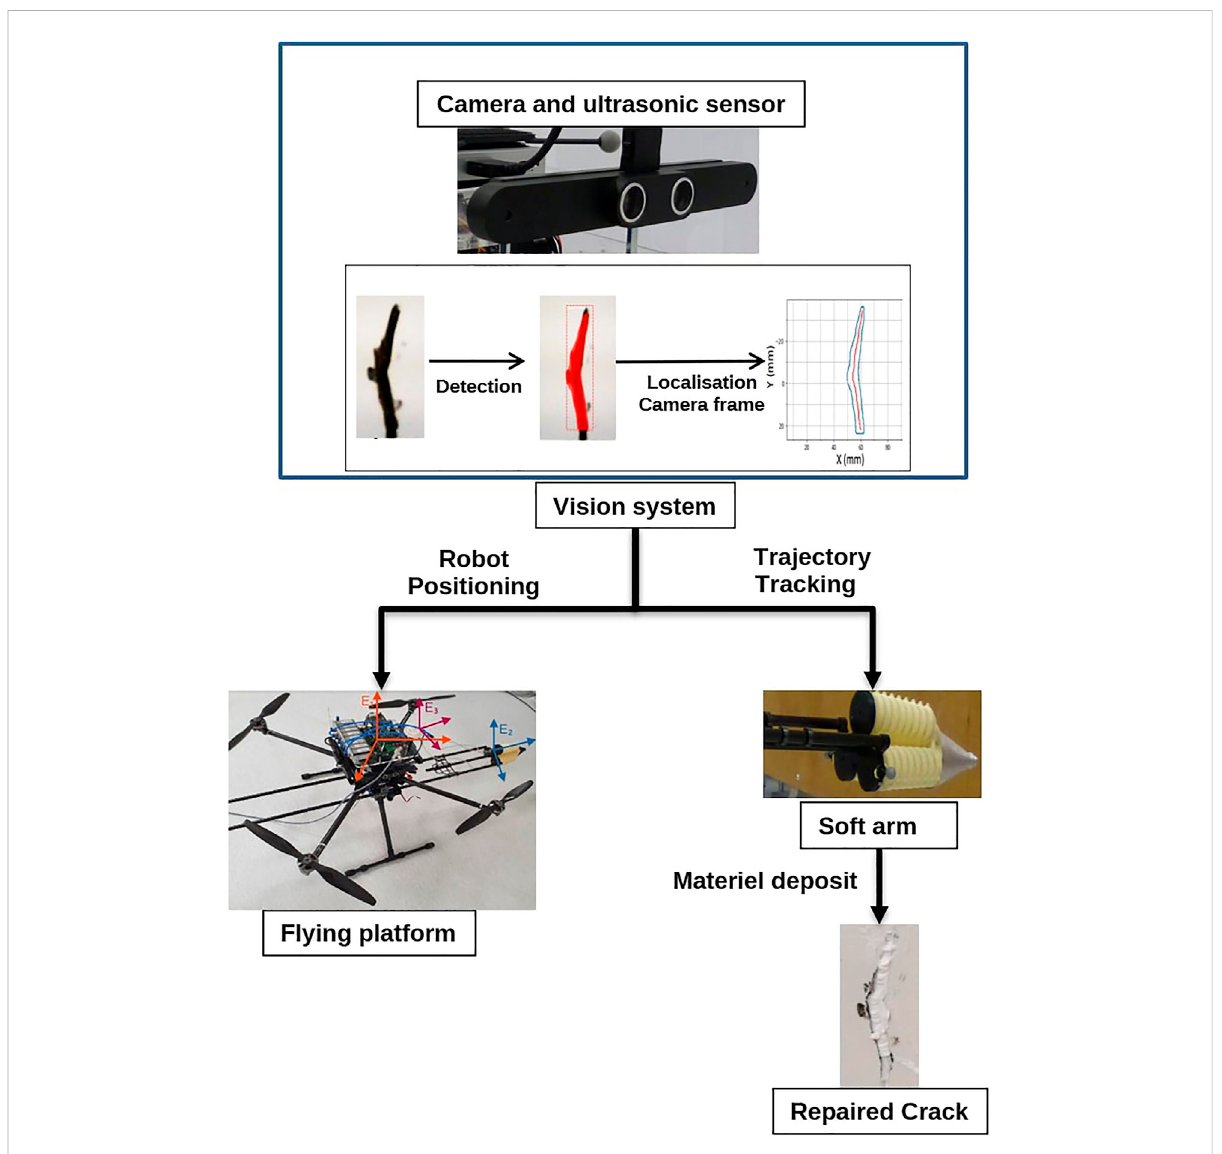
FIGURE 1 Principal of the predictive maintenance